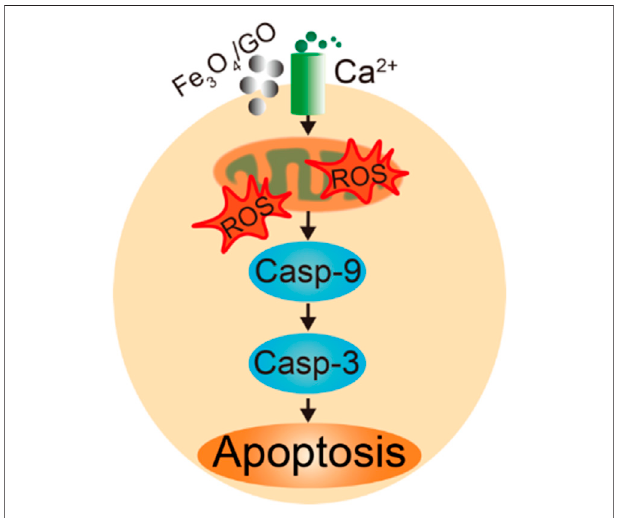
FIGURE 12 | Scheme of HBE cells apoptosis pathway after Fe 3 O 4 /GO